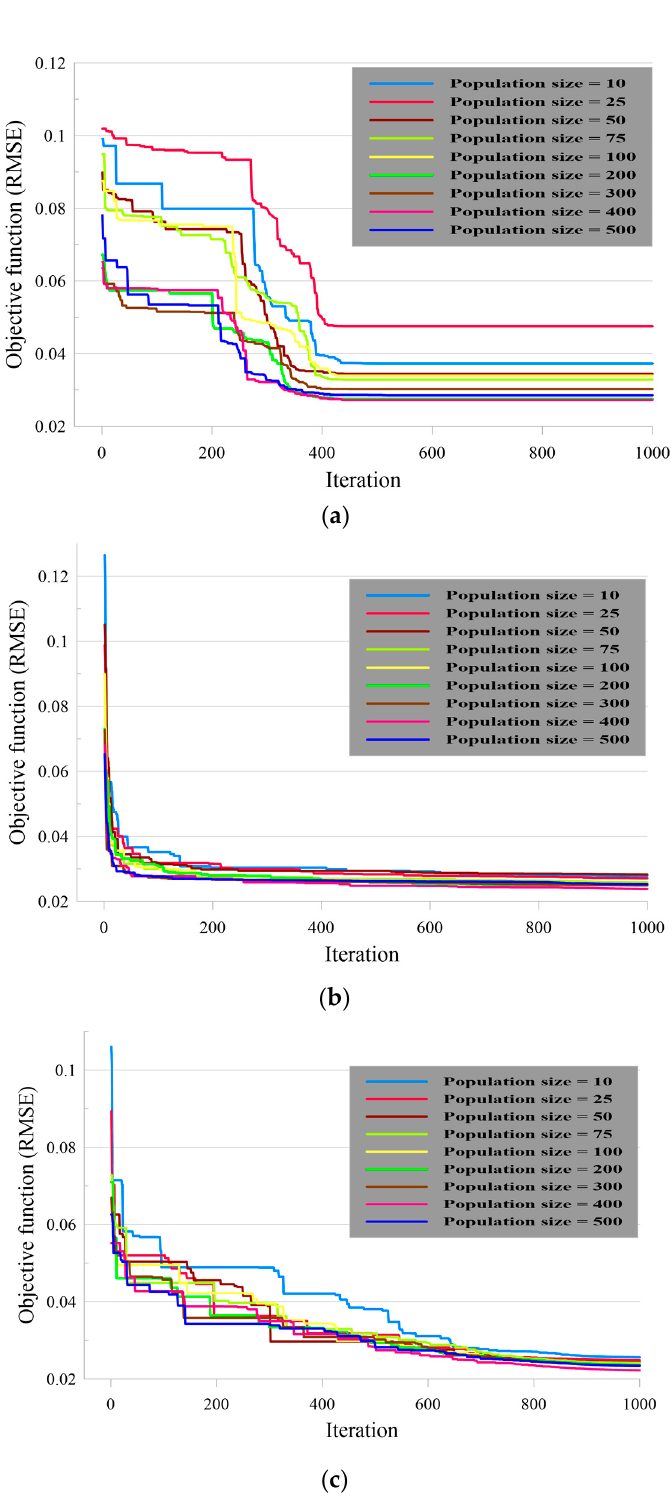
Figure 7. Executed sensitivity analysis for the ( a ) DA-ANN, ( b ) WOA-ANN, and ( c ) IWO-ANN. ANN: artificial neural network, IWO: invasive weed optimization, WOA: whale optimization